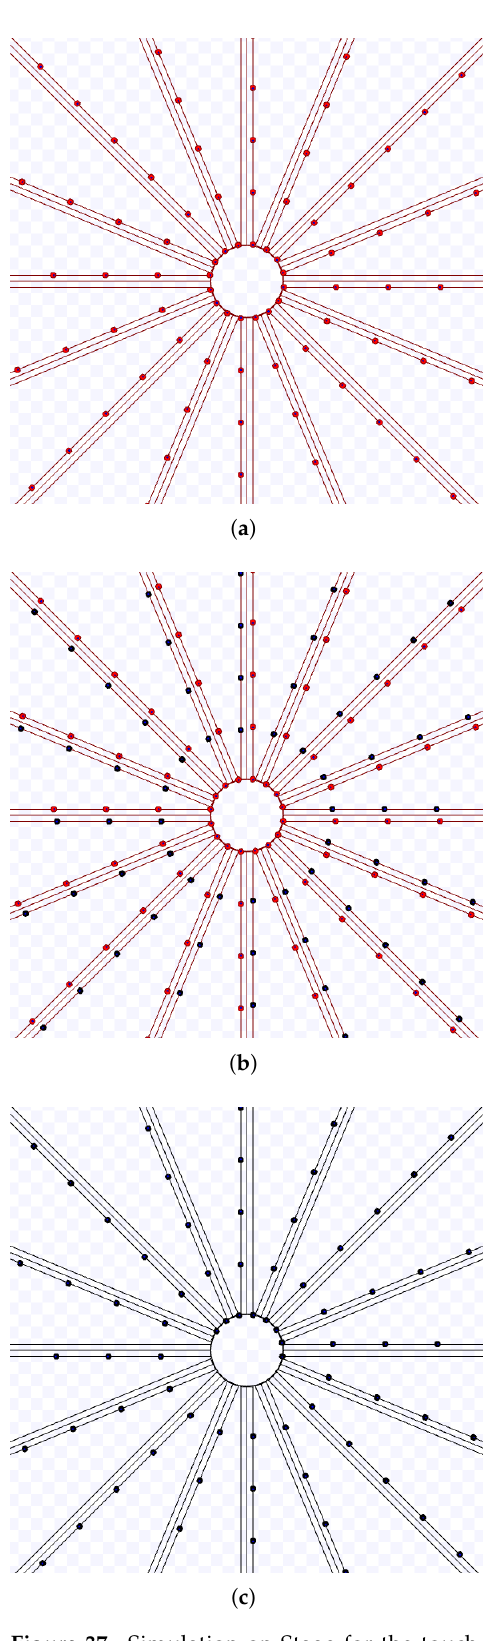
Figure 37. Simulation on Stage for the touch and run strategy using s = 3 m, K = 16 during T = 523.1 s at v = 0.1 m/s. Available on https://youtu.be/FvAqv0zD4_Y, accessed on 12 June 2022. ( a ) 0 s: beginning of the simulation; ( b ) After 261.6 s; ( c ) 523.1 s: ending of the